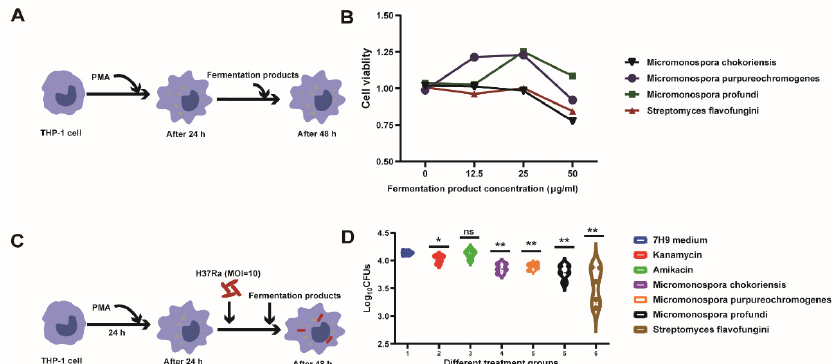
Figure 3. Cytotoxicity detection and intracellular anti- M. tb activities of fermented production. ( A , B ) A cell viability assay was used to detect the toxicity of selected fermented products on THP-1 cells. ( C , D ) Procedure for testing the susceptibility of intracellular fermented products in THP-1 cells and the CFU enumeration of M. tb H37Ra in THP-1 cells treated with individual fermented products for 48 h post-infection. Data presented as mean ± SEM. All experiments were performed in triplicate. The values of *, p < 0.05; **, p < 0.01 were considered statistically significant differences.